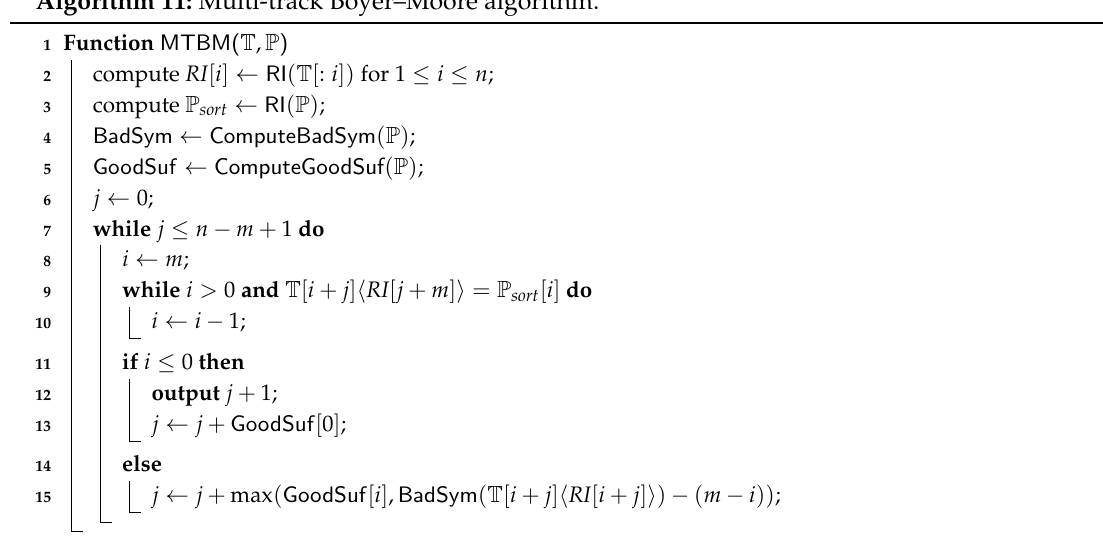
Algorithm 11: Multi-track Boyer–Moore